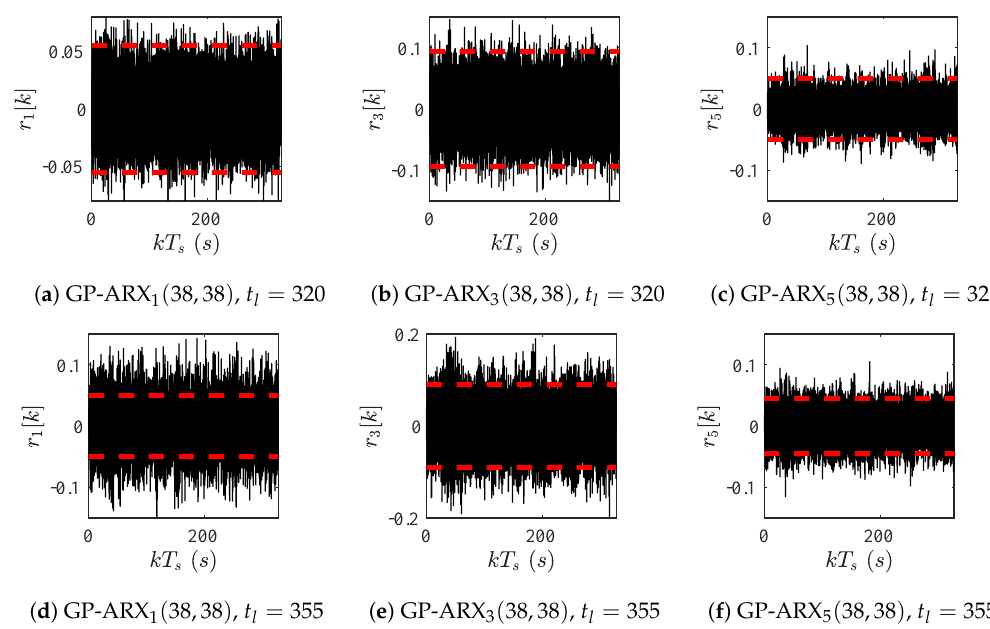
Figure 12. Spring-mass-damper: evolution of the residuals during two long time-scale instants from the validation set.